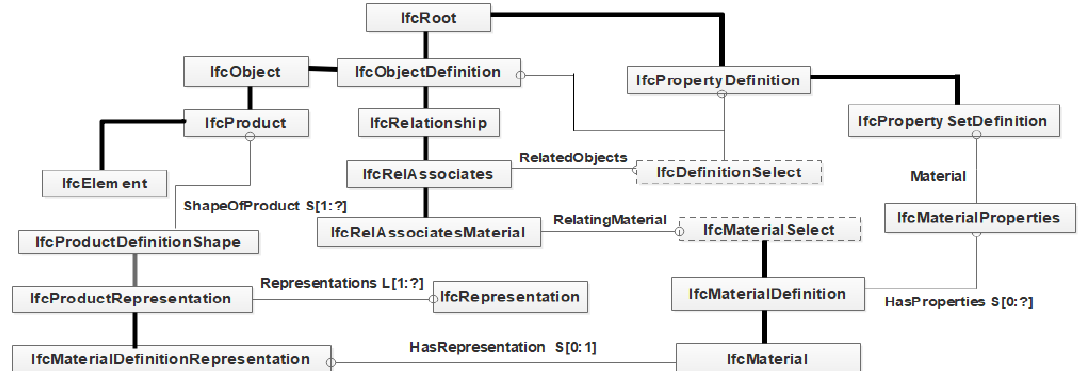
Figure 3. Express-G expression model of component materials based on IFC.